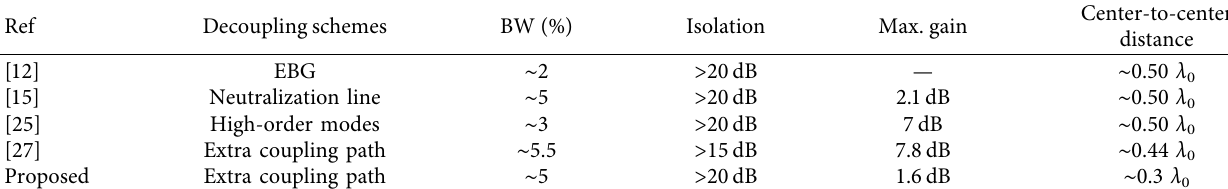
Table 1: Comparisons of the decoupling performance between antenna